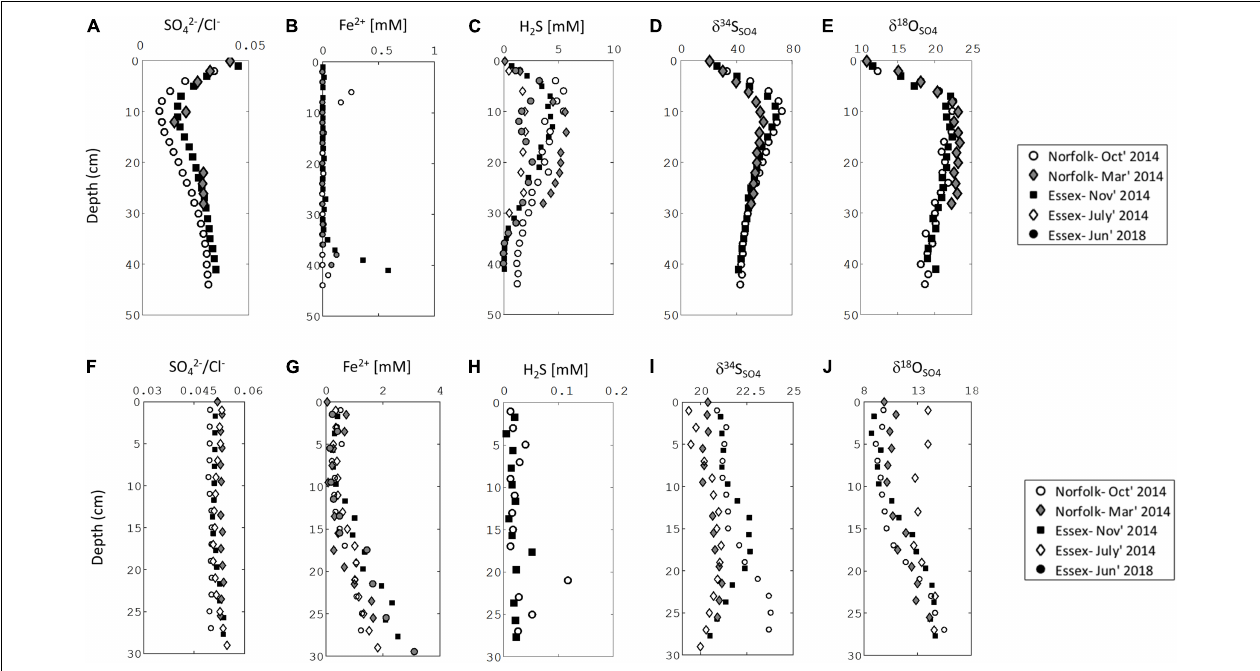
FIGURE 3 | Pore water chemical profiles of 3 iron-rich and 3 sulfide-rich sediment cores taken from Norfolk and Essex. Sulfide-rich sediment: (A) sulfate to chloride ratio, (B) ferrous iron, (C) sulfide, (D) sulfur isotope ratio in sulfate, (E) oxygen isotope ratio in sulfate. Iron-rich sediment: (F) sulfate to chloride ratio, (G) ferrous iron, (H) sulfide, (I) sulfur isotope ratio in sulfate, (J) oxygen isotope ratio in